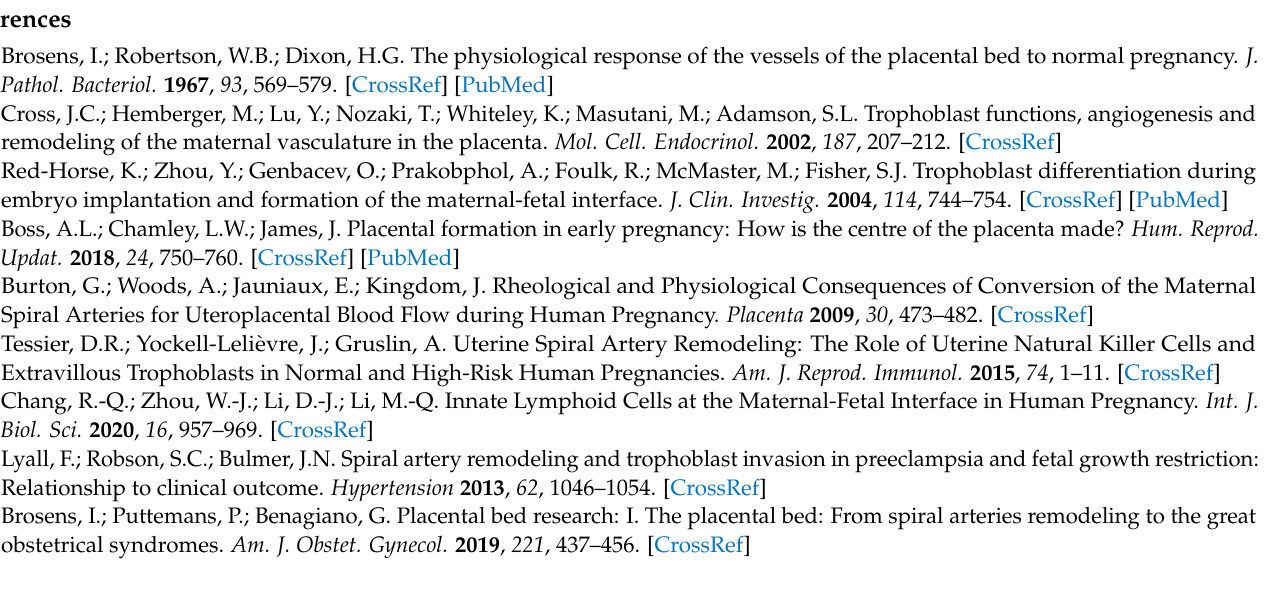
cells. Figure S2: Flow cytometry gating strategy: HTR-8 ± HMC-1 assay. Figure S3: Flow cytometry gating strategy: HTR-8 ± rhuCMA1 assay. Table S1: MMPs and TIMPs expression in supernatant of HTR-8 cells co-cultured with HMC-1 or treated with